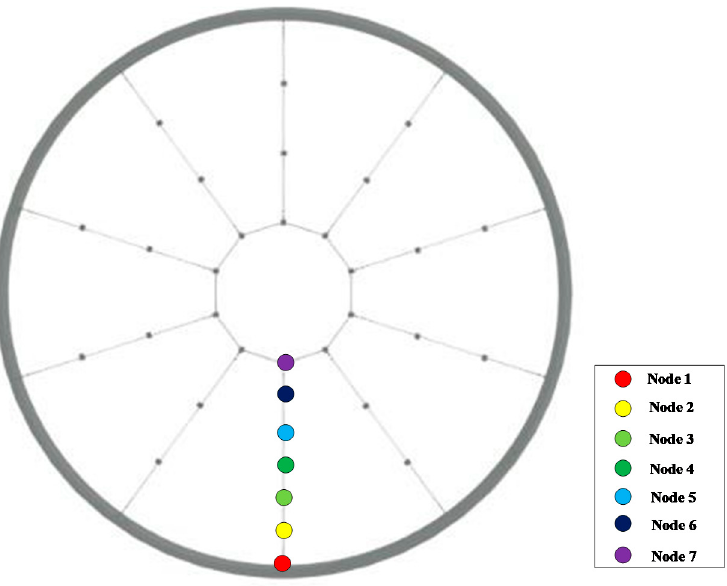
Figure 6. Schematic diagram of the selection of nodes.